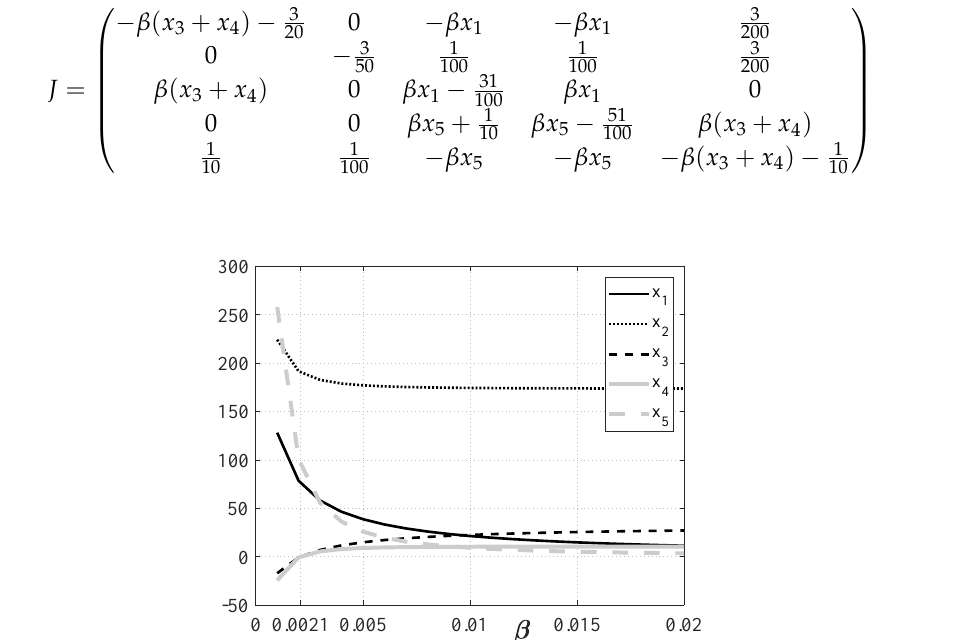
Figure 2. Evolutions of the five components of the point P 2 .